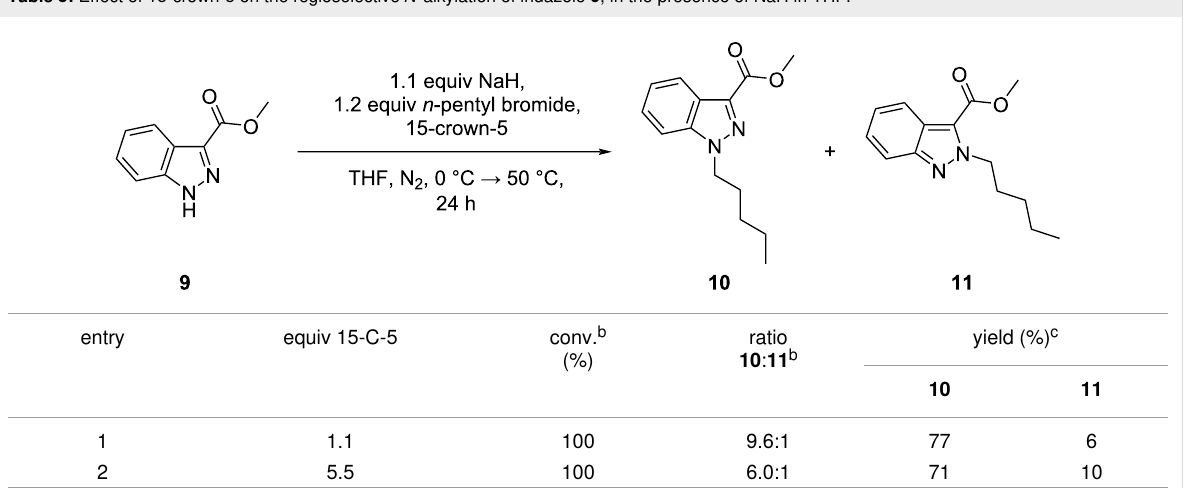
Table 5: Effect of 15-crown-5 on the regioselective N -alkylation of indazole 9 , in the presence of NaH in THF.